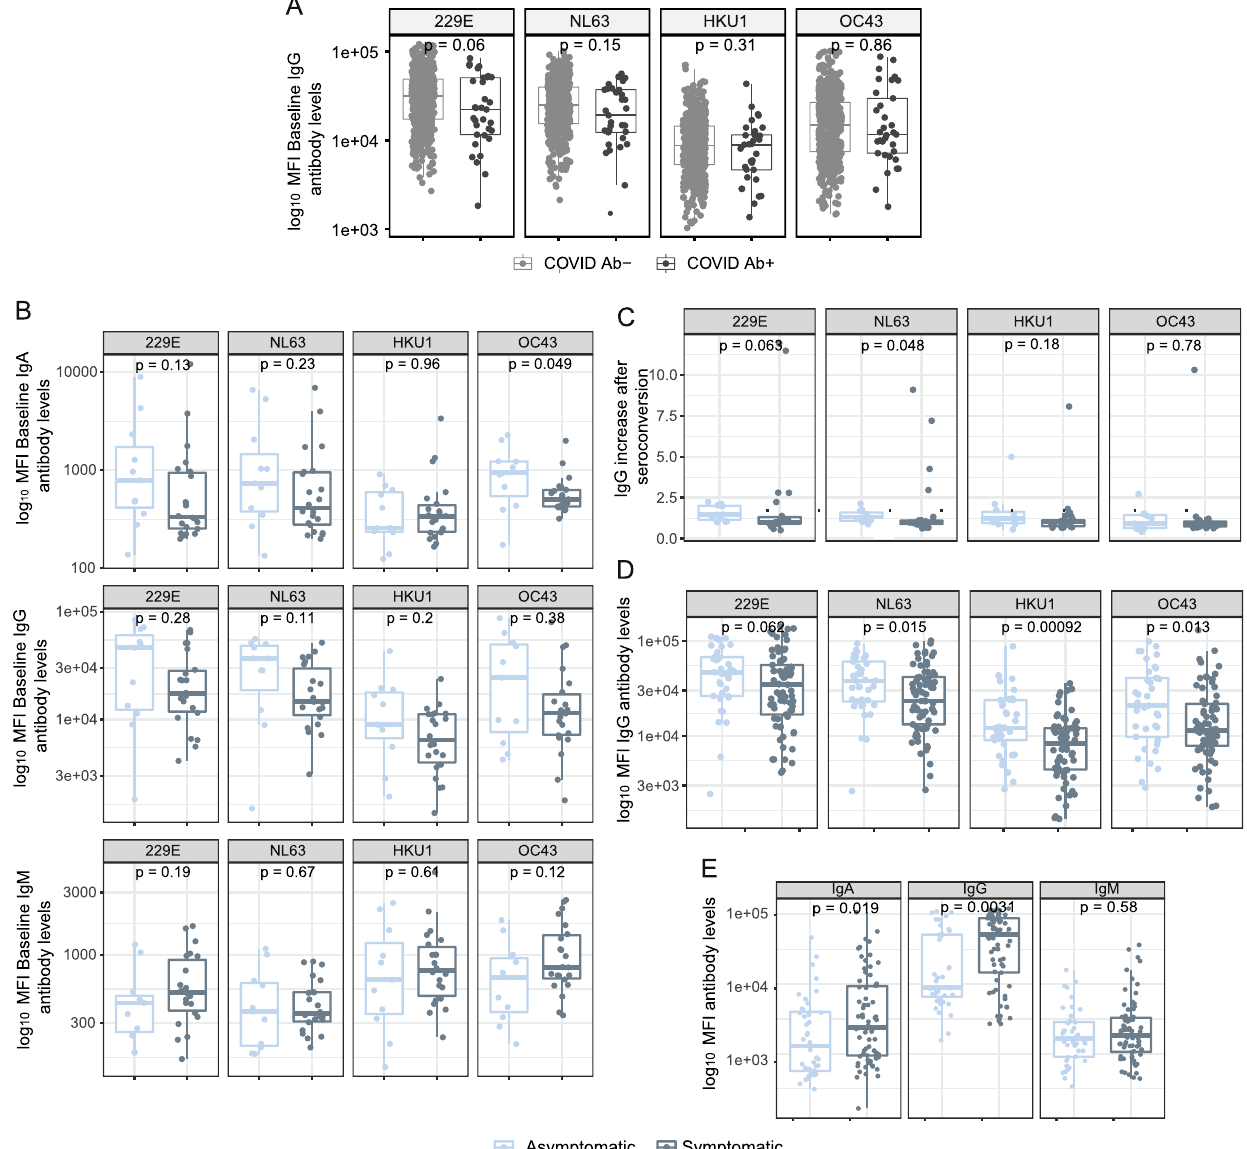
Fig. 4 The in fl uence of anti-HCoV antibody levels on the antibody response to SARS-CoV-2. A Differences in baseline levels (median fl uorescence intensity, MFI) of IgG against HCoV N proteins between participants who were seronegative during the entire study (COVID-19 Ab-) and participants who seroconverted (COVID-19 Ab + ) ( n = 468). B Differences in IgA, IgG and IgM levels prior to infection against N of the four HCoVs between symptomatic and asymptomatic participants who seroconverted during the study ( n = 33). C Differences in fold-increase of IgG levels against N of the four HCoVs after SARS-CoV-2 seroconversion in symptomatic vs asymptomatic COVID-19 cases ( n = 33). D Differences in anti-HCoV N IgG levels at seroconversion visit between symptomatic and asymptomatic SARS-CoV-2 seropositive participants ( n = 110). E Differences in anti-SARS-CoV-2 N IgG, IgA and IgM levels in asymptomatic versus symptomatic participants at seroconversion visit ( n = 110). The center line of boxes depicts the median values; the lower and upper hinges correspond to the fi rst and third quartiles; the distance between the fi rst and third quartiles corresponds to the interquartile range (IQR); whiskers extend from the hinge to the highest or lowest value within 1.5 × IQR of the respective hinge. Two-sided Wilcoxon rank test was used to assess statistically signi fi cant differences in antibody levels between